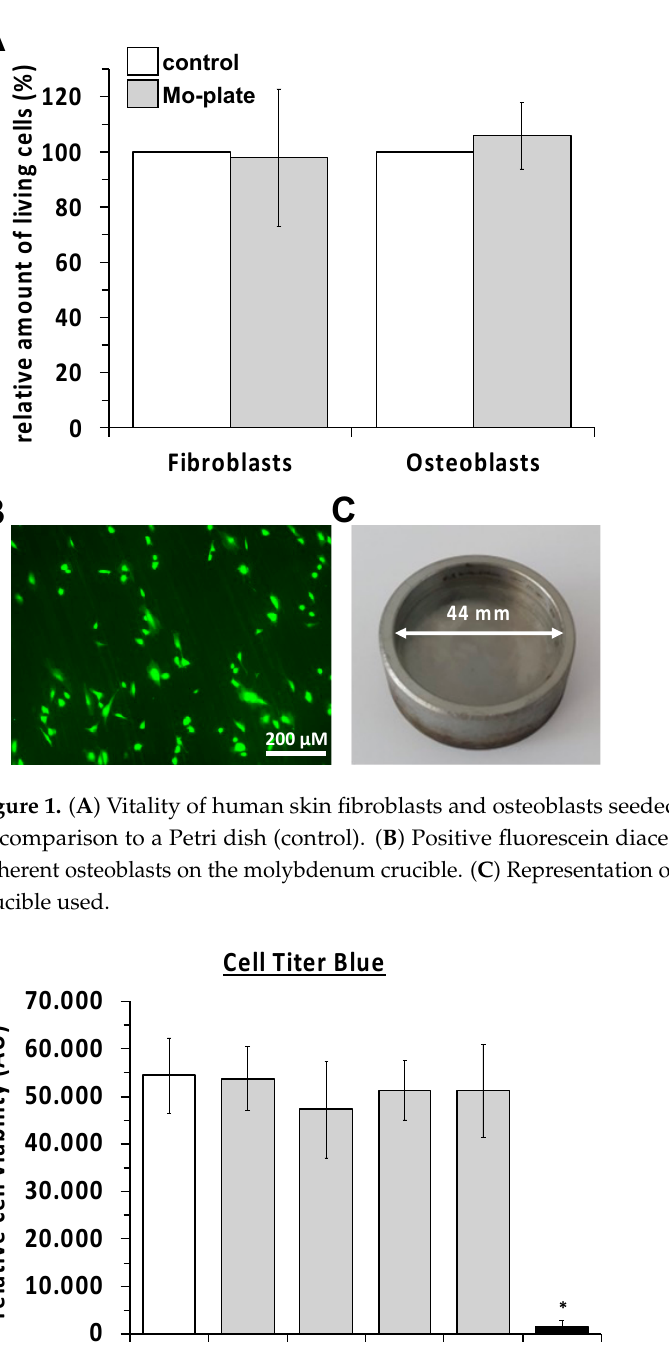
Figure 2. Cell titer blue assay with L929 mouse fibroblast cells *, p < 0.05 as compared to the control (paired two-tailed Student’s t -test).